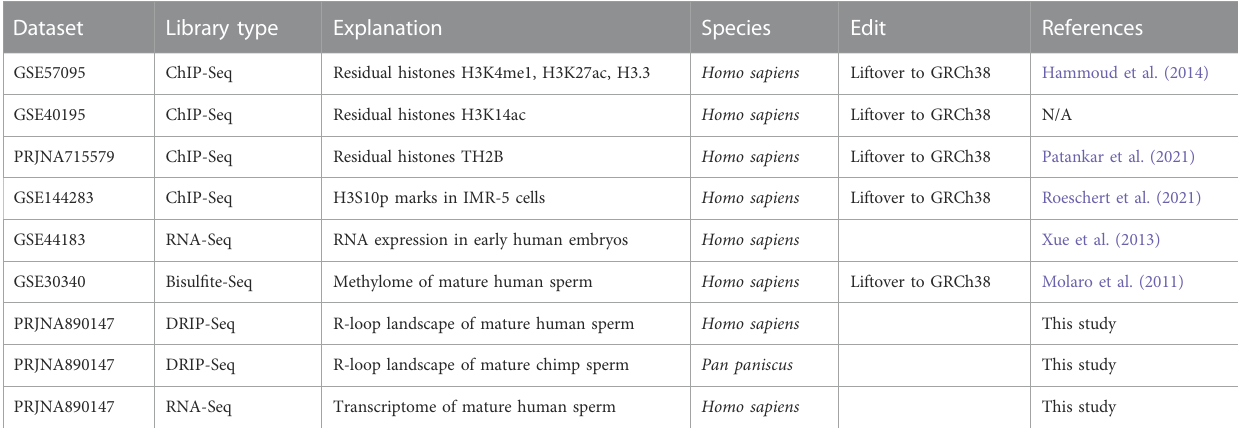
TABLE 1 The information of the used